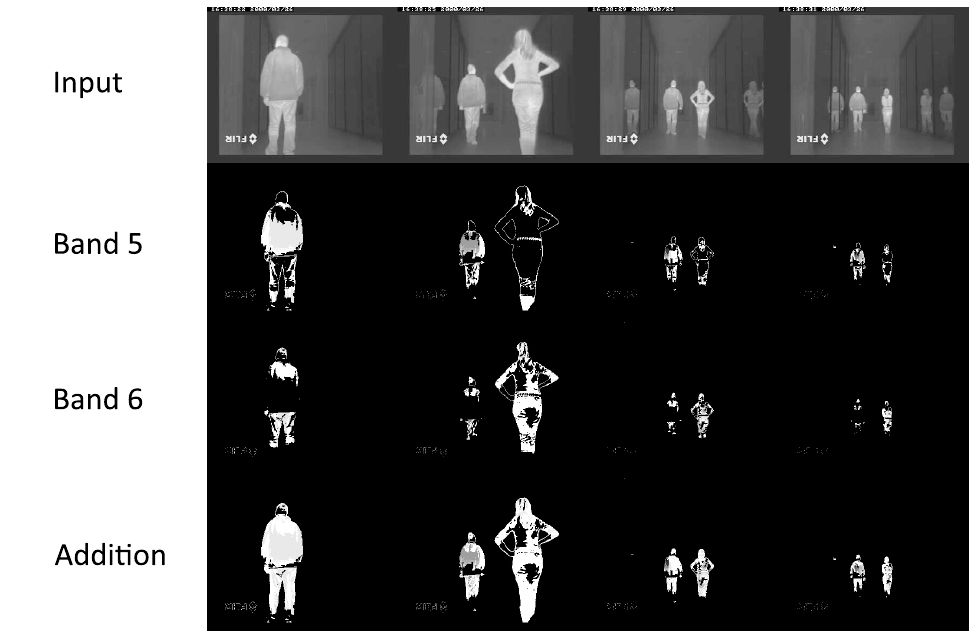
Figure 7. Addition of AC detection modules corresponding to bands 5 and 6 for efficient infrared-based people